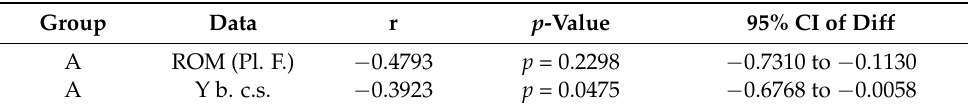
Table 7. Correlation (Pearson R coefficient test) between epimysial fascia Ultrasound measurements and Y balance test (composite score; asymmetry), ROM, within group. Only statistically significant data are